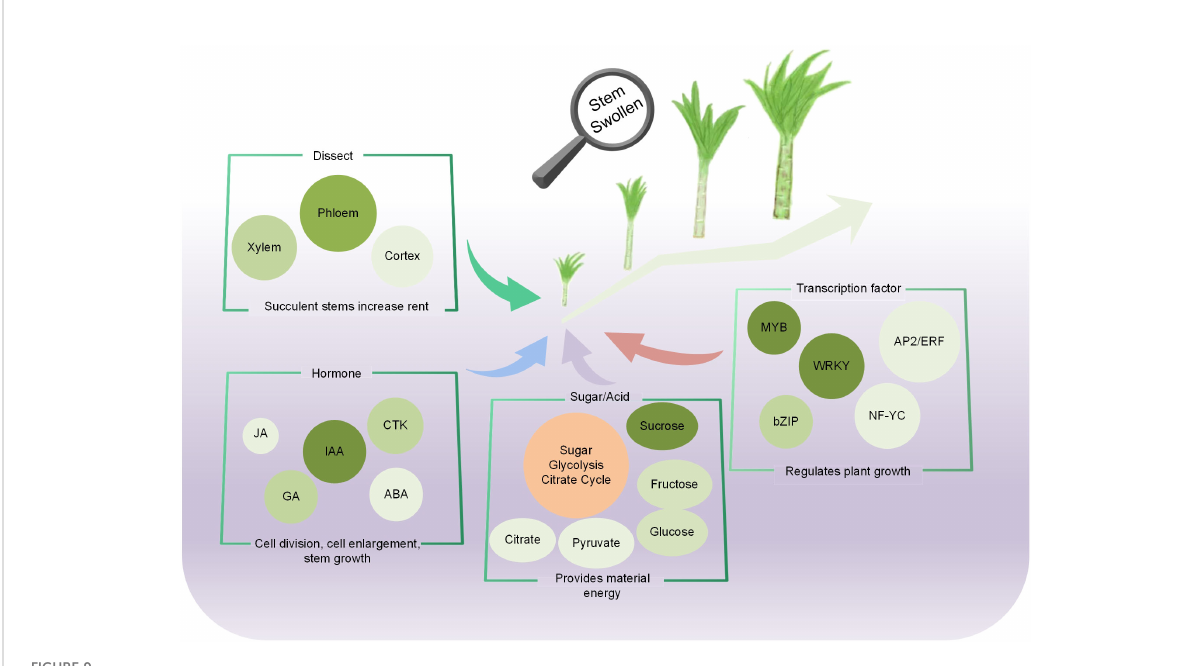
FIGURE 9 Regulation pattern of the fl eshy stem expansion in stem